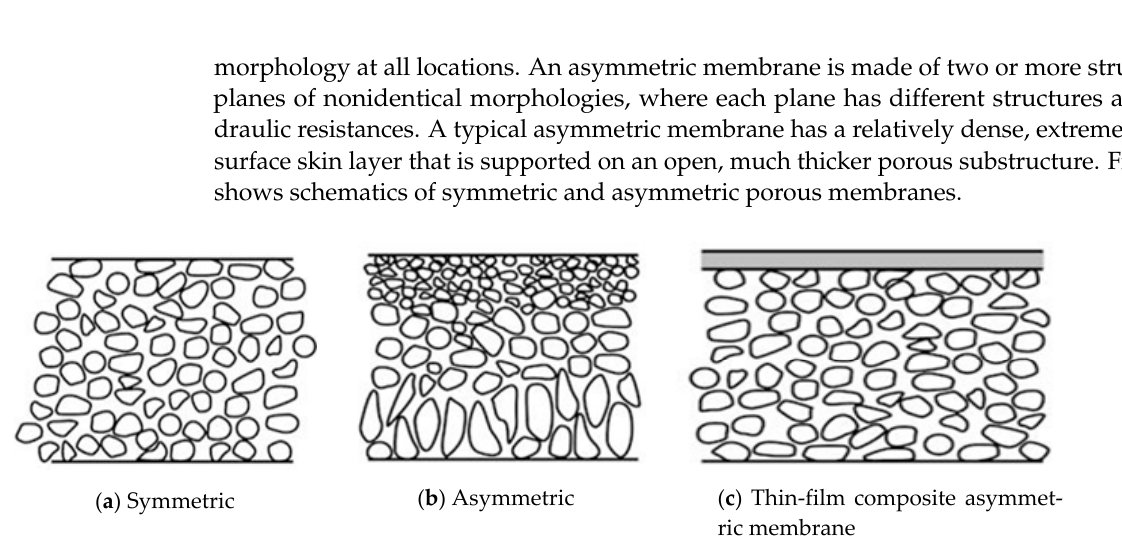
Figure 1. Symmetric and asymmetric porous membranes. In symmetric membranes, the pore structure is, to a large extent, homogeneous, whereas it is not for asymmetric membranes.